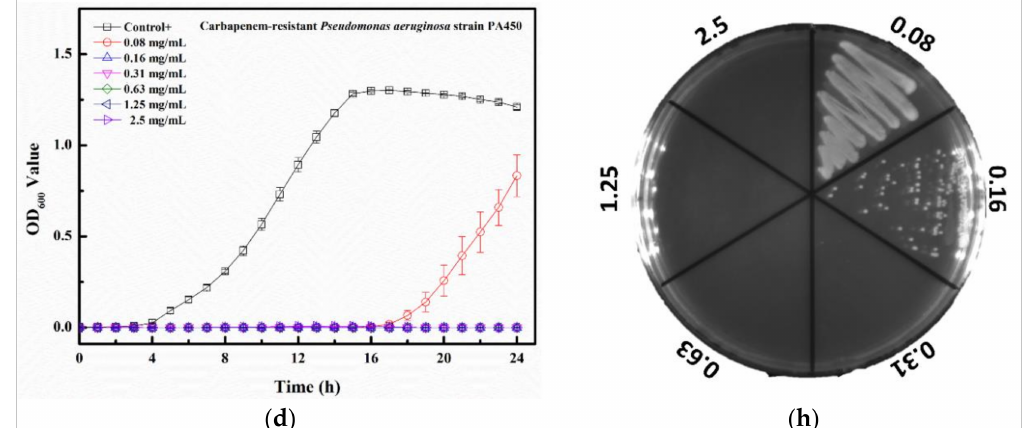
Figure 10. Growth curve results for Tau-Ag against ( a ) vancomycin-resistant E. feacium (VRE) clinical isolate V47, ( b ) carbapenem-resistant K. pneumoniae (CRKP) ATCC BAA-1705, ( c ) carbapenem-resistant A. baumannii (CRAB) clini- cal isolate AB03, and ( d ) carbapenem-resistant P. aeruginosa (CRPA) clinical isolate PA450. The results represent absorbance at 600 nm, with dots as means and bars as SD. Colony-forming tests results for ( e ) VRE V47, ( f ) CRKP ATCC BAA-1705, ( g ) CRAB AB03, and ( h ) CRPA